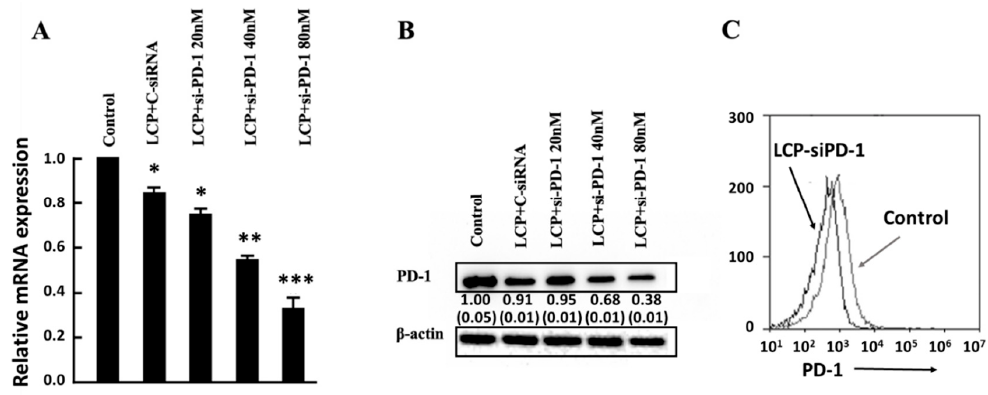
Figure 5. Down-regulation of PD-1 in TILs using LCP NPs. ( A ) Real-time PCR data for the knockdown efficiency of PD-1 mRNA in TILs treated with LCP+si-PD-1 at the concentration from 20 to 80 nM for 4 h; ( B ) Western-blot showing reduction of PD-1 expression in TILs treated similarly. The tests were done in triplicate, with the SEM listed in the parenthesis. ( C ) Flow cytometry of TILs before and after treatment with LCP-si-PD-1 at 40 nM. All of the tests were done in triplicate.